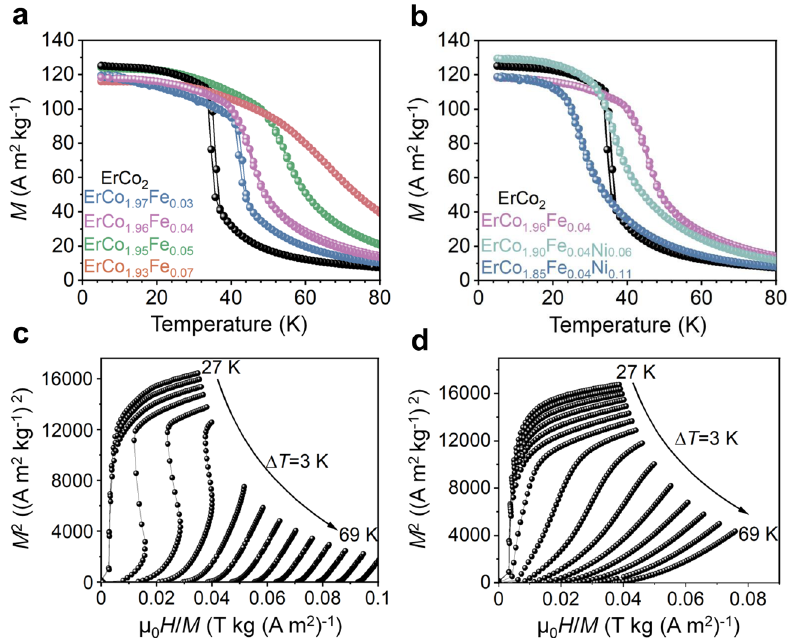
Fig. 2 Tuning the transition temperature, thermal hysteresis, and order of magnetic phase transition in an ErCo 2 -based system. a , b The Magnetisation ( M ) is plotted versus temperature at an applied magnetic fi eld of 1T showing that the transition temperature can be tuned to higher temperatures ( a ) and to lower temperatures ( b ), while eliminating the hysteresis by substituting Co by Fe and Fe + Ni in the ErCo 2 -based system. The colours of the curves in a , b correspond to the colour of listed alloy compositions. c , d The Arrott plots measured from 27 K to 69 K at a temperature step ( △ T ) of 3 K for c ErCo 2 and d ErCo 1.95 Fe 0.05 alloy show the changes of the phase transition from fi rst-order to second-order,